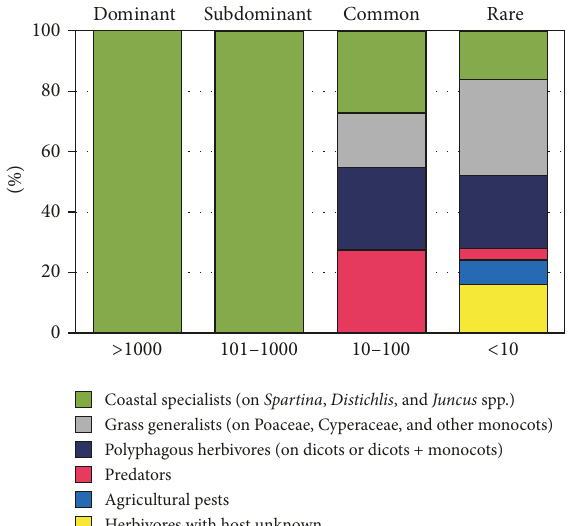
Figure 1: Stacked bar chart showing the host-abundance pattern of the members of Auchenorrhyncha and Heteroptera, collected in Louisiana salt marshes in the Mississippi Delta. 𝑋 -axis represents classes of abundance with corresponding species group names and a number of collected specimens per species. Comments in the text. The range pattern of the group of common species was also different from that of the dominant and subdominant groups.